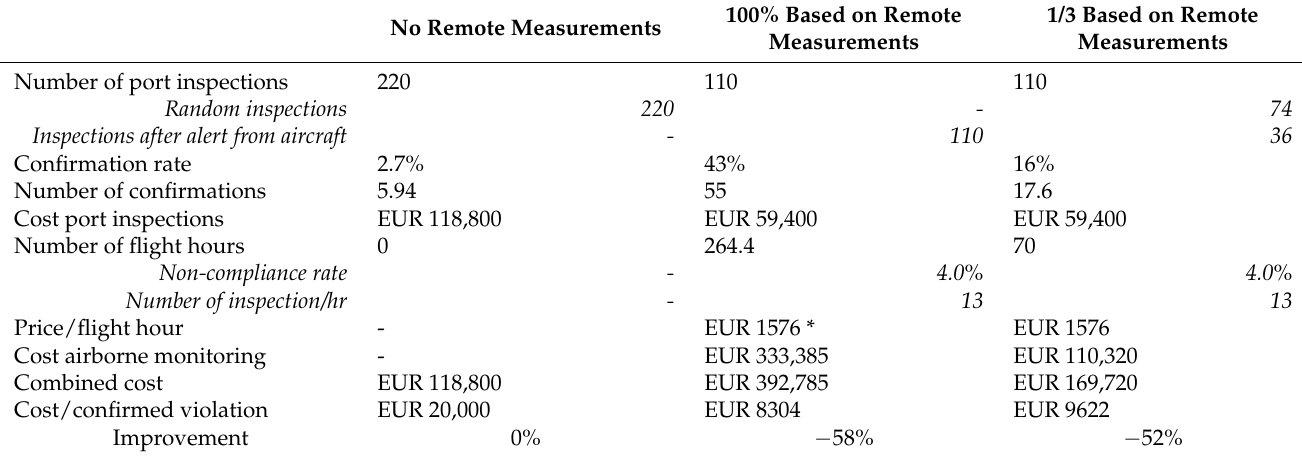
Table 5. Cost calculation per confirmed